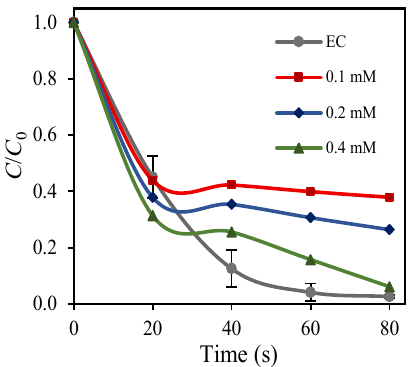
Figure 5. Comparison of RhB degradation in the EC system under 0.06 M NaCl vs. chemical oxidation at different NaOCl concentrations.